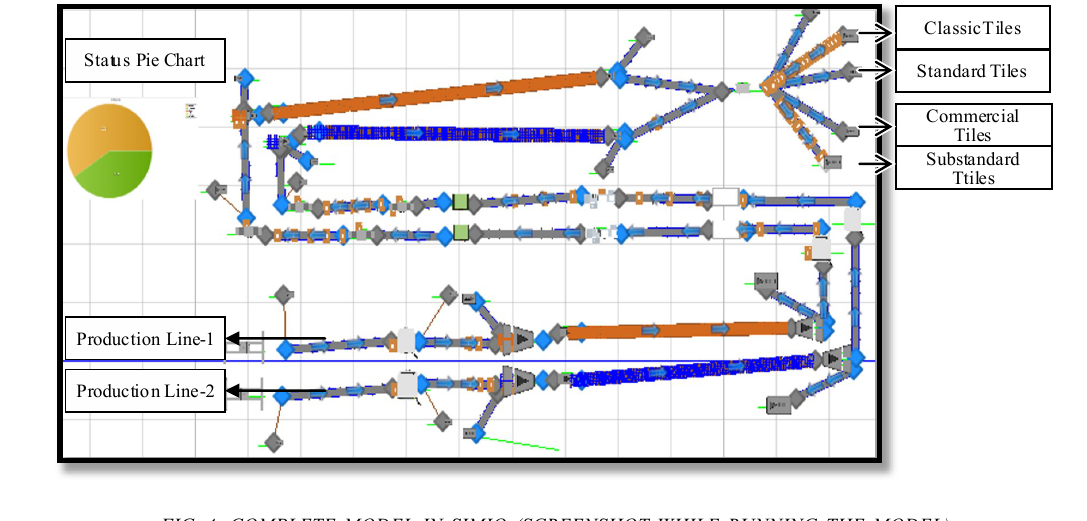
FIG. 4. COMPLETE MODEL IN SIMIO (SCREENSHOT WHILE RUNNING THE MODEL)